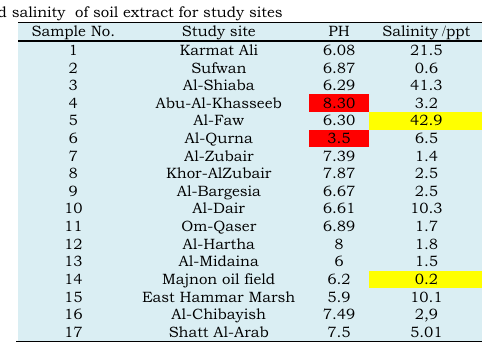
Table 2 pH and salinity of soil extract for study sites Sample No.